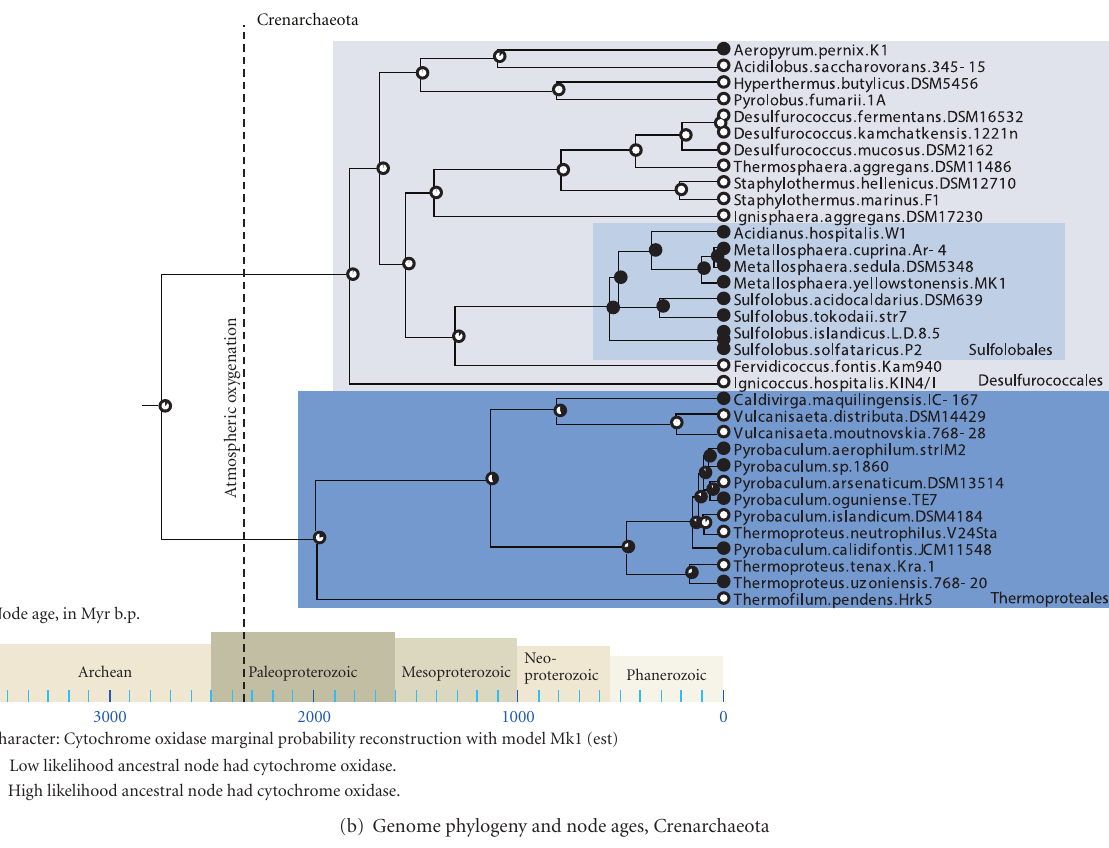
Figure 1: Genome phylogeny and node ages. Node ages (scale at bottom, in millions of years before present) were inferred using relaxed molecular clock method penalized likelihood. The presence of a cytochrome oxidase (subunit I or subunit I+III from either Heme-copper oxygen reductase family A1 or B) was coded in Mesquite as 0 = absence in the genome or 1 = presence in the genome. The maximum likelihood method (implementing the Mk1 model) was used to estimate the probability that each ancestral genome in the tree (each node) contained a cytochrome oxidase gene. A completely white circle indicates zero likelihood of a cytochrome oxidase gene; a completely black circle indicates a 100% likelihood, while intermediate shading of the pie indicates an intermediate likelihood. The corresponding geologic age of the nodes in the tree can be determined using the age diagram at the bottom. The archaeal tree was split into two figures, (a) one showing the Euryarchaeota and the other (b) showing the Crenarchaeota, for ease of viewing. Major archaeal clades are indicated using colored boxes, with the appropriate family names